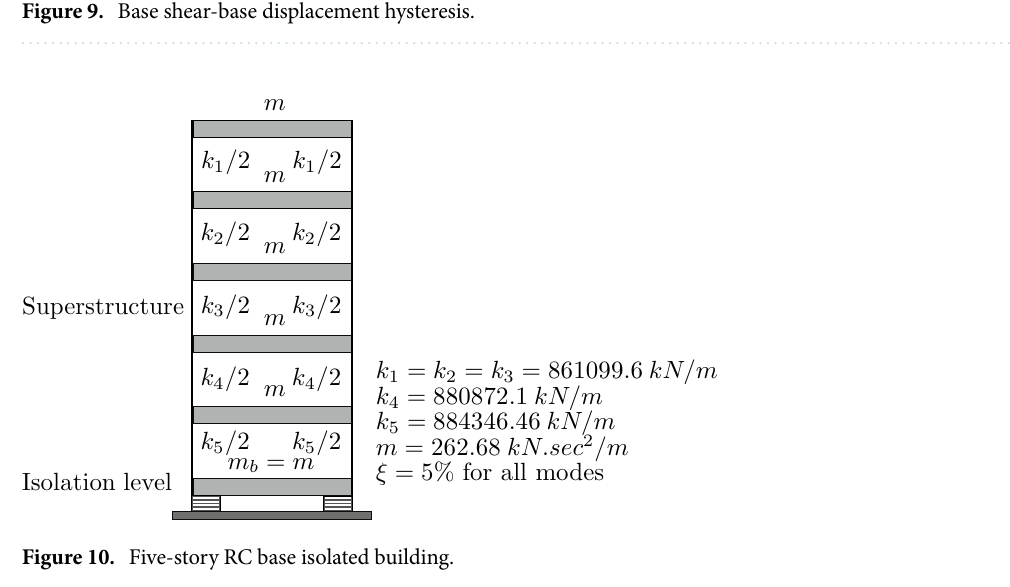
Figure 9. Base shear-base displacement hysteresis.